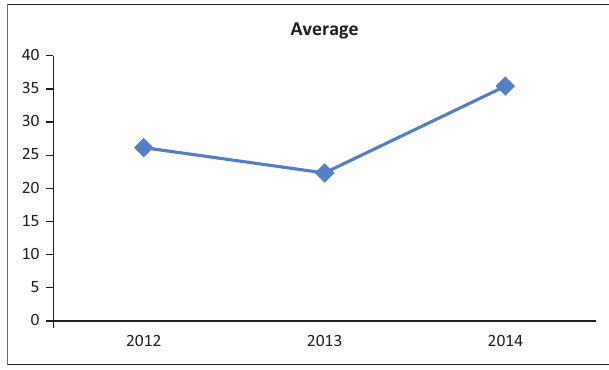
FIGURE 3: Trend of learners’ mathematics performance over